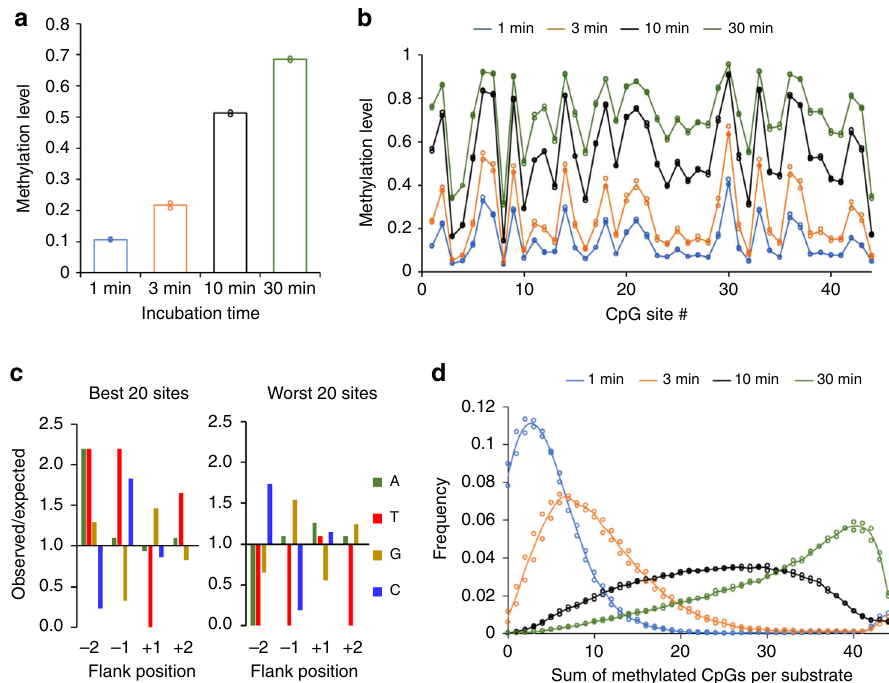
Fig. 1 Deep enzymology methylation data of the hemimethylated 349 bp substrate. a Time course of the overall methylation levels. b Time dependence of the methylation pro fi le of the 44 CpG sites. c Enrichment and depletion of individual bases at different fl anking positions in the most preferred and most disfavored CpG sites in ( b ). d Single molecule analysis showing the fraction of DNA molecules with different number of methylated CpG sites. The bars in ( a ), ( b ), and ( d ) display the average of two independent experiments. Source data are provided as a Source Data fi